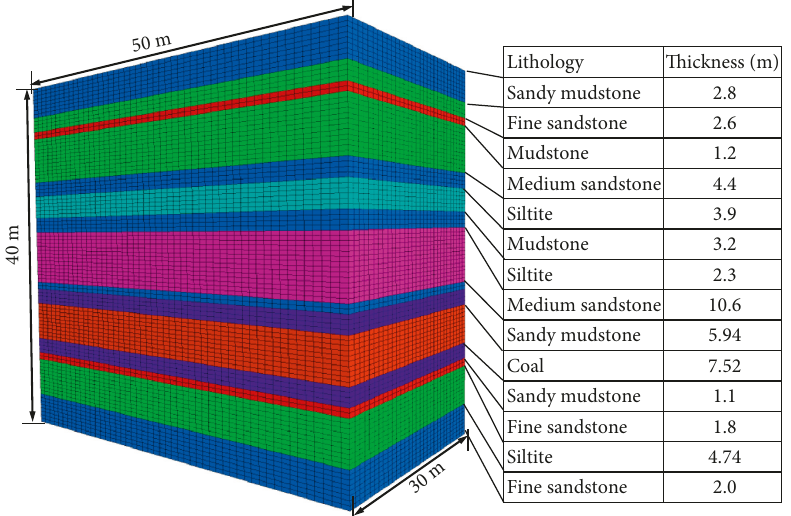
Figure 6: Simulation model.